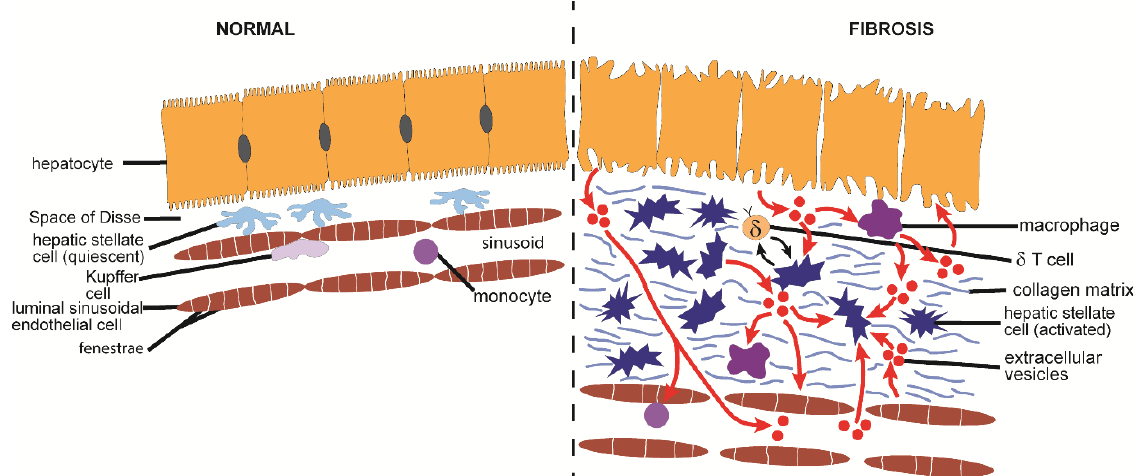
Figure 6. Proposed EV pathways in the pathogenesis of hepatic fibrosis. Hepatocytes that are injured by exposure to hepatitis viruses, alcohol, or free fatty acids produce increased numbers of EVs due to activation of EV biogenic components (e.g., ROCK-1) and suppression of autophagy-associated late endosomes. These EVs drive activation and function in macrophages or HSC, or alternatively are released into the circulation. Production by macrophages of pro-inflammatory cytokines (e.g., IL-1 β , IL-6) occurs upon interactions of hepatocyte EVs with TLR and DR5 as well as stimulation of NF- κ B- activated NLRP3 inflammasomes. Hepatocyte EVs also stimulate TLR3 expression in HSC which causes HSC activation and drives an IL-17A positive feedback loop between HSC and δ T cells that exacerbates inflammation and fibrosis. HSC activation and fibrogenesis is directly stimulated by hepatocyte EVs and involves various mechanisms such regulation of PPAR γ by EV miR-128-3p, -27b, -130b, Smad 7 by EV miR-27a, Nrld2 by miR-181, SOCS3 by EV miR-19a, TGF- β by miR-192, and miR-26b and its collagen 1 α 2 target by EV MALAT. HSC themselves release EVs that are enriched in PDGF α , bind to HSC integrins and heparan sulfate proteoglycans, and stimulate HSC migration, activation, and fibrogenesis. EVs produced downstream of activation of apoptosis signaling regulating kinase 1 or HIF-1 during HSC activation deliver GLUT1 and PKM2 to quiescent HSC, KC or LSECs and are pro-fibrogenic in part due to suppressed EV miR-30a levels and a proteomic cargo that is enriched for ECM-, proteasome- and collagen-associated components. AKT activation and migration in HSC is stimulated by EVs from liver sinusoidal endothelial cells while vascular endothelial cells undergo tube formation in response to VEGF-enriched EVs from fibrotic myofibroblasts and demonstrate enhanced adhesion to monocytes in the presence of integrin- β 1-enriched EVs from lipotoxic hepatocytes. Activated macrophages produce miR-103-3p-eriched EVs that stimulate HSC activation and fibrogenesis via suppression of KLF4 . EVs in serum or plasma from fibrotic patients activate HSC and are likely derived from injured hepatocytes (e.g., NAFLD, alpha-1 antitrypsin deficiency) or mast cells (e.g., systemic mastocytosis). Only cells with a demonstrated role in EV production or response are shown; some of the depicted EV pathways are deduced from in vitro observations and have not been demonstrated in vivo. See text for